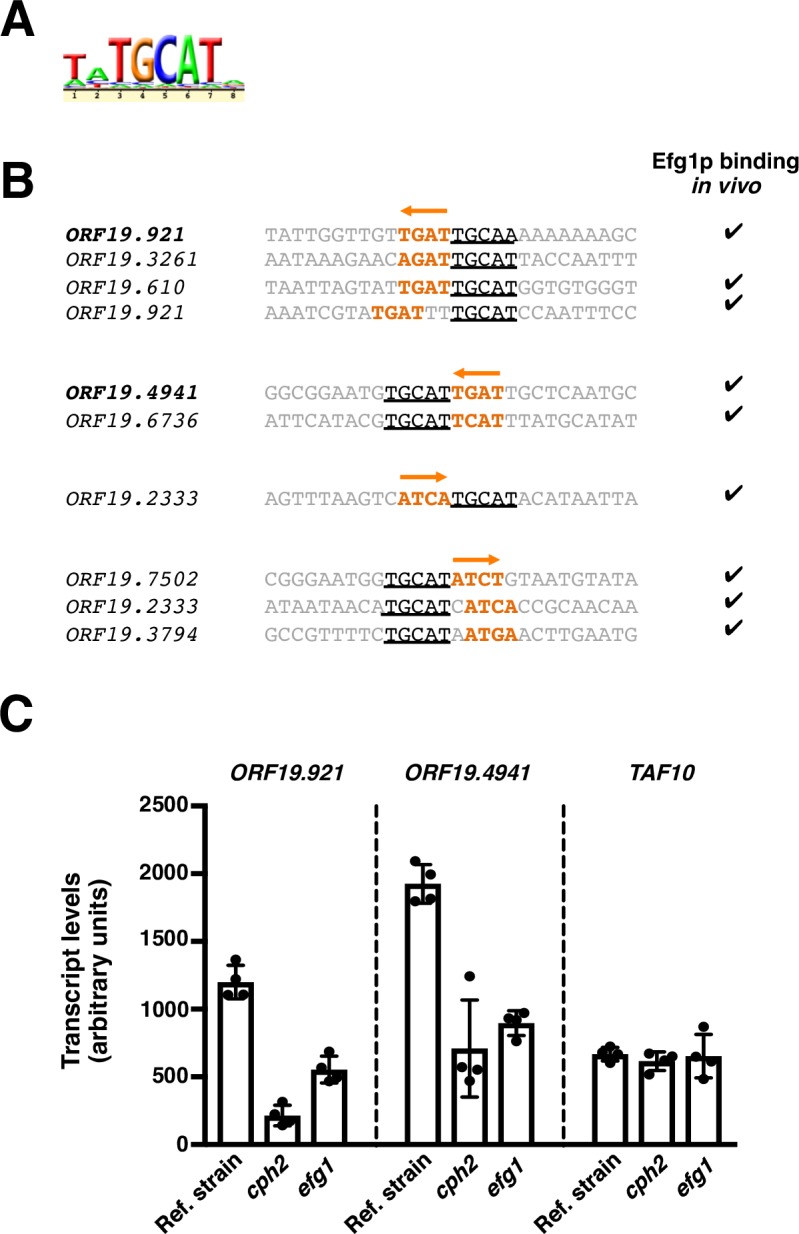
Co-occurrence of Cph2p and Efg1p DNA binding sequences.(A) Putative Efg1p motif identified in the set of DNA sequences occupied in vivo by Cph2p. (B) Distribution of Cph2p and Efg1p DNA binding sites in a subset of the sequences occupied by Cph2p. Putative Cph2p sites are shown in orange whereas the predicted Efg1p sites are underlined. Check marks to the right indicate whether Efg1p has been found to bind in vivo to the respective target promoter [35]. (C) CPH2 and EFG1 co-regulate the expression of target genes. Total RNA was prepared from wild-type, cph2 and efg1 deletion mutant strains after a 24-hour incubation under anaerobic conditions (37°C). ORF19.921, ORF19.4941 and TAF10 (control) transcript levels were determined by quantitative real-time PCR. Plotted are the mean and SD of four biological replicates. Asterisks denote statistically significant differences compared to the reference strain.